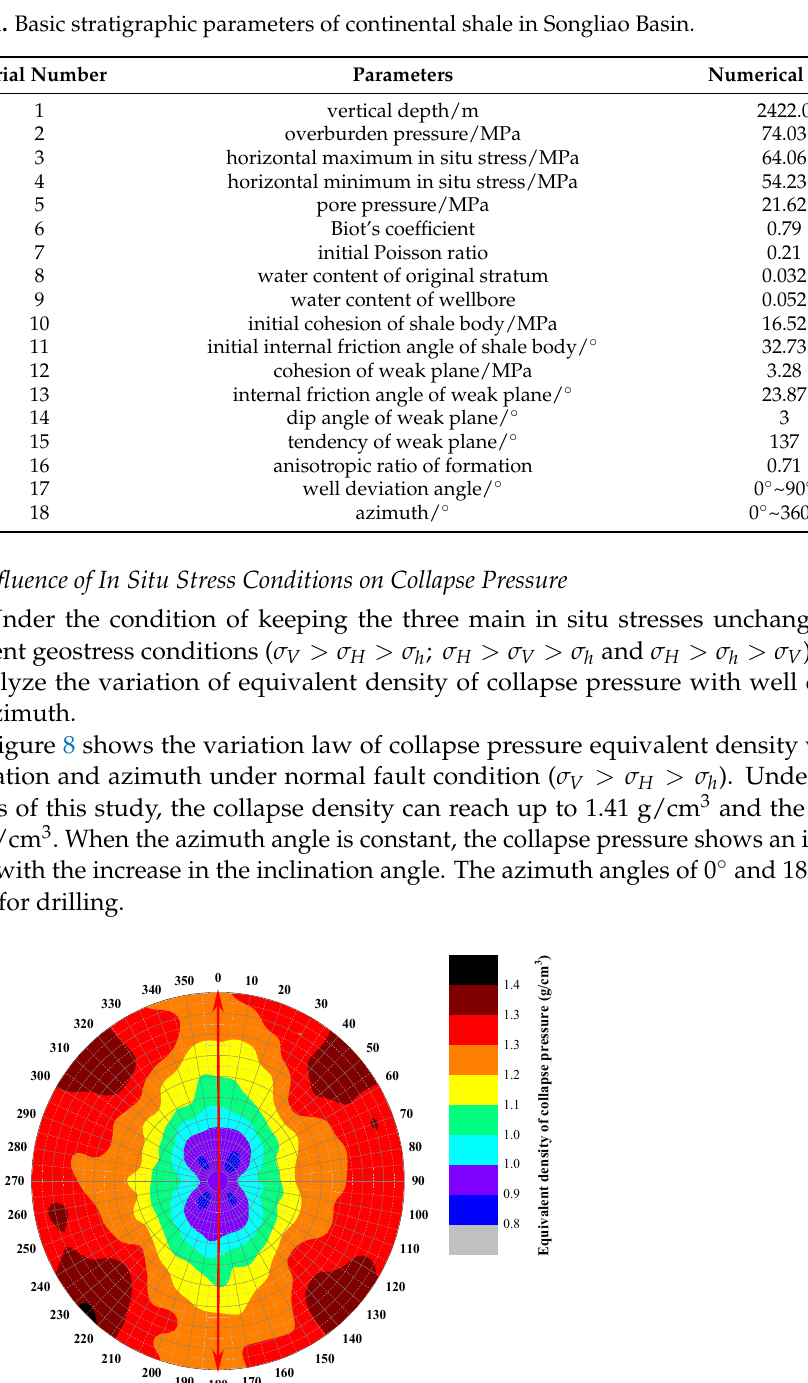
Figure 8. Under normal fault condition ( σ V > σ H > σ h